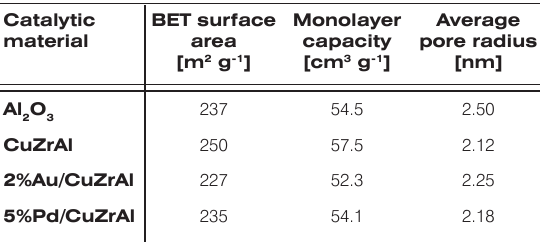
Table 1. Results of BET surface area, monolayer capacity and average pore radius. Catalytic material